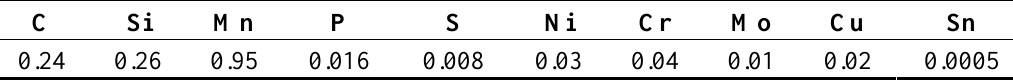
Table 2. Chemical composition of reinforcing steel (%).